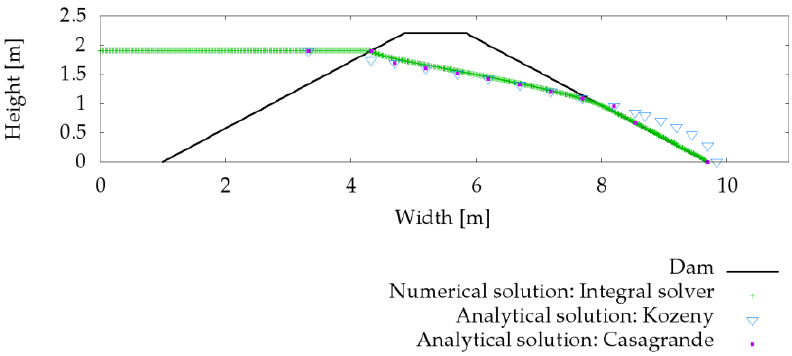
Figure 4. Seepage through a homogeneous dam after Kozeny [45], Casagrande [48] and calculated with the integral solver.